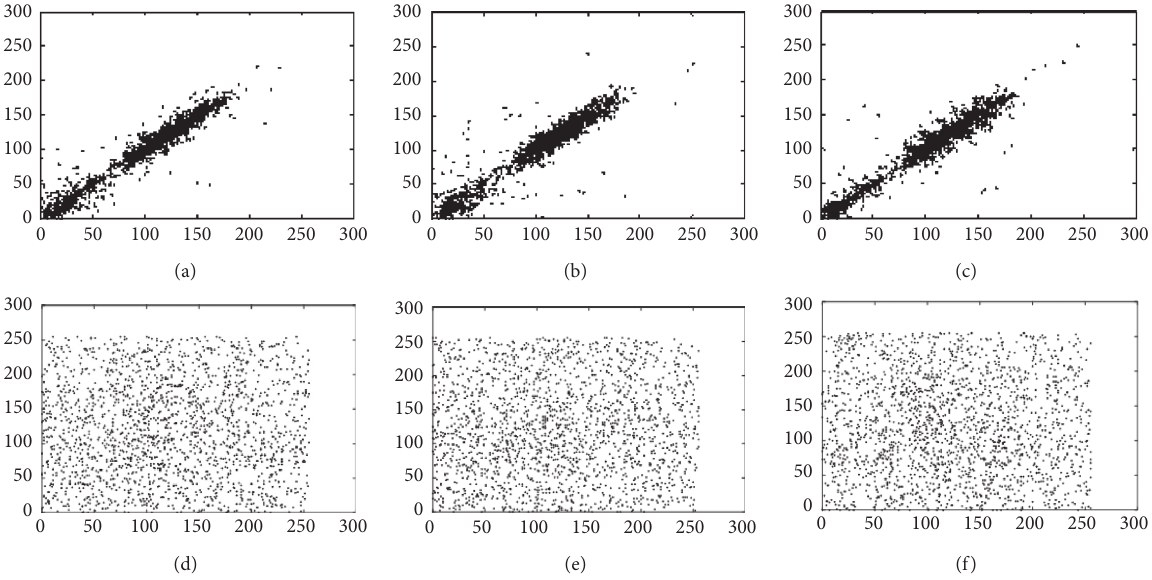
Figure 6: Correlation of two adjacent pixels (unscaled). (a) Vertical direction in the original image. (b) Horizontal direction in the original image. (c) Diagonal direction in the original image. (d) Diagonal direction in the encrypted image. (e) Horizontal direction in the encrypted image. (f) Diagonal direction in the encrypted